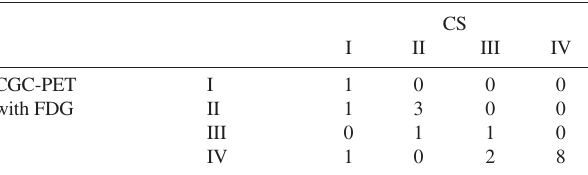
Table 2 - Conventional staging (CS) versus staging using